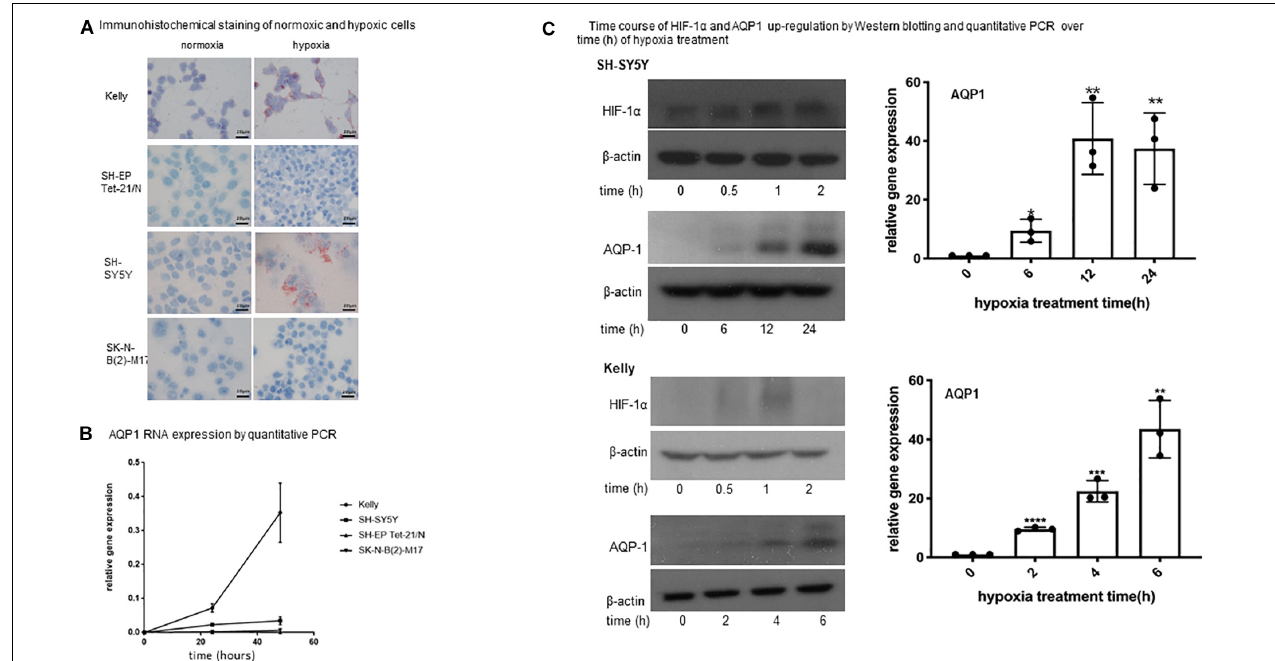
FIGURE 1 | Expression of AQP1 in neuroblastoma cells under hypoxia . (A) Immunohistochemical staining of normoxic and hypoxic cells. Exposure of neuroblastoma cell lines Kelly, SH-SY5Y, SK-N-B(2)-M17 and SH-EP Tet-21/N to hypoxia (1% O 2 ) for 48 h leads to an increased APQ1 protein expression (red staining) in Kelly and to a lesser extent in SH-SY5Y cells. SK-N-B(2)-M17 and SH-EP Tet-21/N cells do not show any expression (microscopy at x100). The experiment was performed in quadruplicate and performed twice. (B) AQP1 mRNA expression by quantitative PCR. Relative expression of AQP1 mRNA increases with time under hypoxia in Kelly and to a lesser extent in SH-SY5Y cells. SK-N-B(2)-M17 and SH-EP Tet-21/N cells only show an insignificant increase (values at 0 h compared with 48 h: Kelly p < 0.005, SH-SY5Y p < 0.05, SK-N-B(2)-M17 ns, SH-EP Tet-21/N ns). The experiment was performed in triplicate and repeated. One-way Anova was performed with GraphPad Prism7 after confirming normal distribution followed by Dunnet’s post-test. The error bars represent one standard deviation. (C) Time course of HIF-1 α and AQP1 up-regulation by Western blotting and quantitative PCR over time (h) of hypoxia treatment. (C) Shows the time course (in hours) of AQP1 and HIF-1 α protein and AQP1 mRNA increase upon exposure to hypoxia treatment in SH-SY5Y and Kelly cells. While HIF-1 α protein increases quickly upon hypoxic stimulation in both cell lines, the reaction time of AQP1 protein occurrence varies between cell lines. AQP1 expression in Kelly cells has started already after 2 h and increases until 6 h, while SH-SY5Y start producing AQP1 later, after around 6 h of treatment, and peak 24 h after onset of hypoxia. AQP1 protein production is consistent with AQP1 mRNA expression. In both cell lines production of AQP1 is following expression of HIF-1 α . The experiment was repeated twice. One-way Anova was performed with GraphPad Prism7 after confirming normal distribution followed by Dunnet’s post-test. The error bars represent one standard deviation.